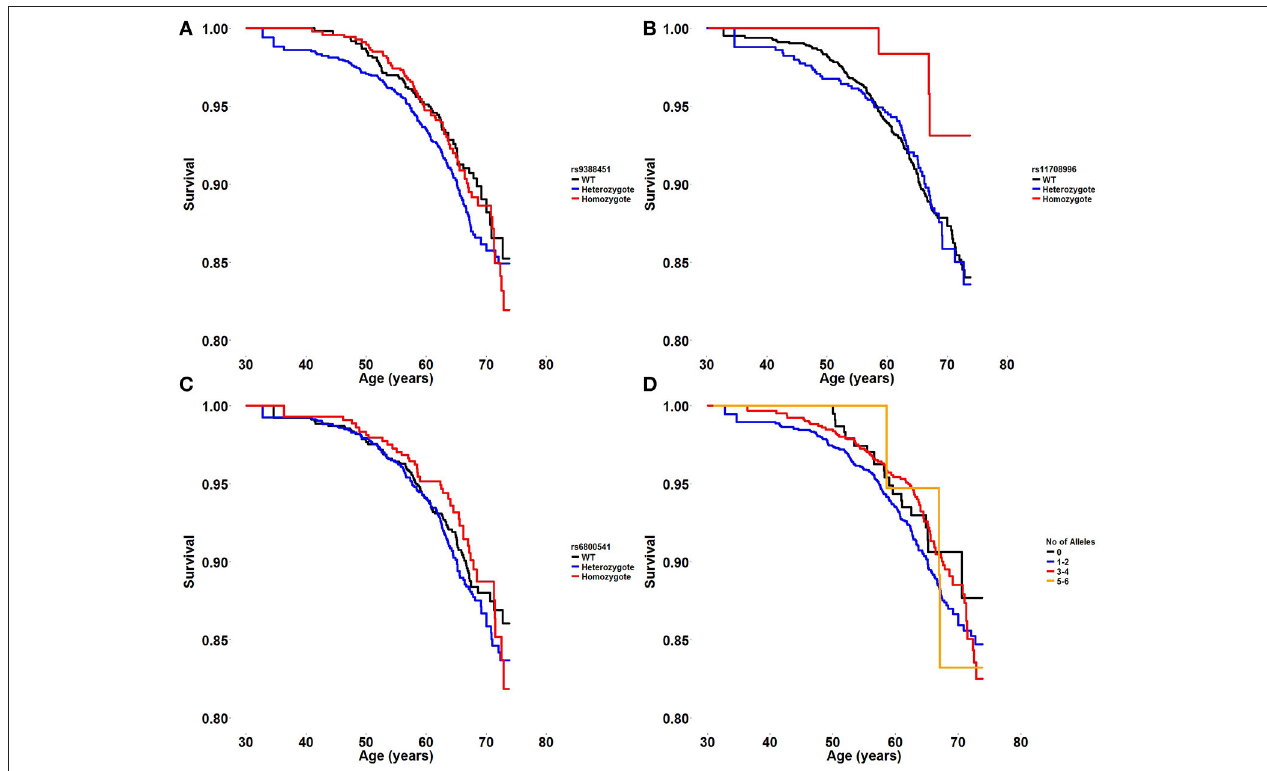
FIGURE 1 | (A–C) Survival plot displaying the probability of survival during follow-up in different age groups in wildtype, heterozygote, and homozygote carriers of three BrS risk alleles; HEY2 rs9388451, SCN5A rs11708996, and SCN10A rs6800541. (D) Survival plot displaying the probability of survival during follow-up in different age groups when carrying 0, 1–2, 3–4, or 5–6 BrS risk alleles.